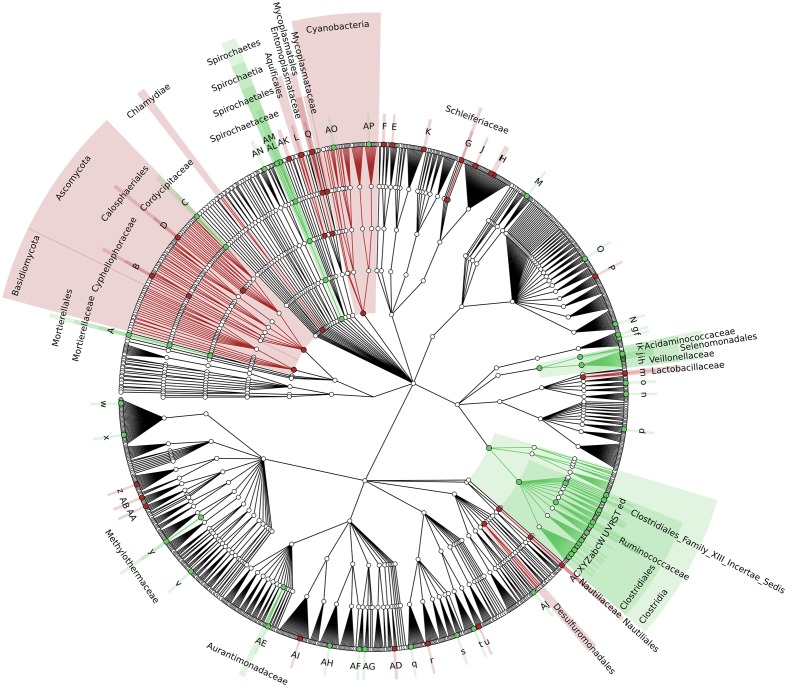
Cladogram illustrating the distribution of taxa with differential abundance between CCs and feces, according to S-MG data. Each dot represents an identified taxon, with taxa higher in CCs colored in green, and those higher in feces in brown. Abbreviations: A, Mortierella; a, Lachnoclostridium; AA, Zymobacter; AB, Marinomonas; AC, Lebetimonas; AD, Candidatus Pelagibacter; AE, Microvirga; AF, Wolbachia; AG, Candidatus Paracaedibacter; AH, Magnetospira; AI, Haematobacter; AJ, Chondromyces; AK, Thermoanaerobaculum; AL, Treponema; AM, Brachyspira; AN, Cloacibacillus; AO, Mastigocoleus; AP, Acaryochloris; B, Cyphellophora; b, Youngiibacter; C, Beauveria; c, Clostridium; d, Oscillibacter; D, Togninia; e, Anaerovorax; E, Segetibacter; f, Dielma; F, Phaeodactylibacter; g, Faecalitalea; G, Schleiferia; H, Algibacter; h, Mitsuokella; I, Psychroserpens; i, Selenomonas; J, Cellulophaga; j, Sporomusa; K, Flexibacter; k, Megasphaera; l, Megamonas; L, Persephonella; m, Lactobacillus; M, Olsenella; n, Alkalibacterium; N, Pseudonocardia; o, Eremococcus; O, Microbispora; P, Dactylosporangium; p, Saccharibacillus; q, Acidovorax; Q, Mycoplasma; r, Azohydromonas; R, Flavonifractor; S, Intestinimonas; s, Thiomonas; t, Chitiniphilus; T, Epulopiscium; u, Conchiformibius; U, Ruminococcus; v, Anaerobiospirillum; V, Anaerotruncus; w, Budvicia; W, Dehalobacter; X, Lachnospira; x, Raoultella; Y, Butyrivibrio; y, Methylohalobius; z, Lysobacter; Z, Shuttleworthia.